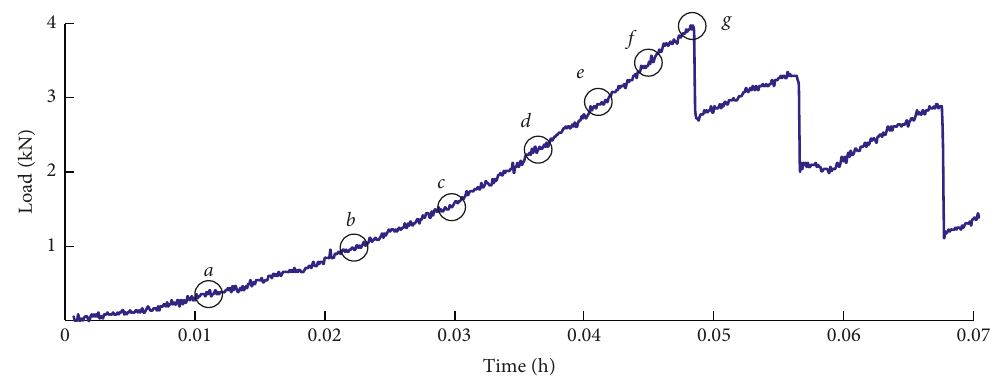
Figure 11: Load-time curve of cracked Brazilian test.